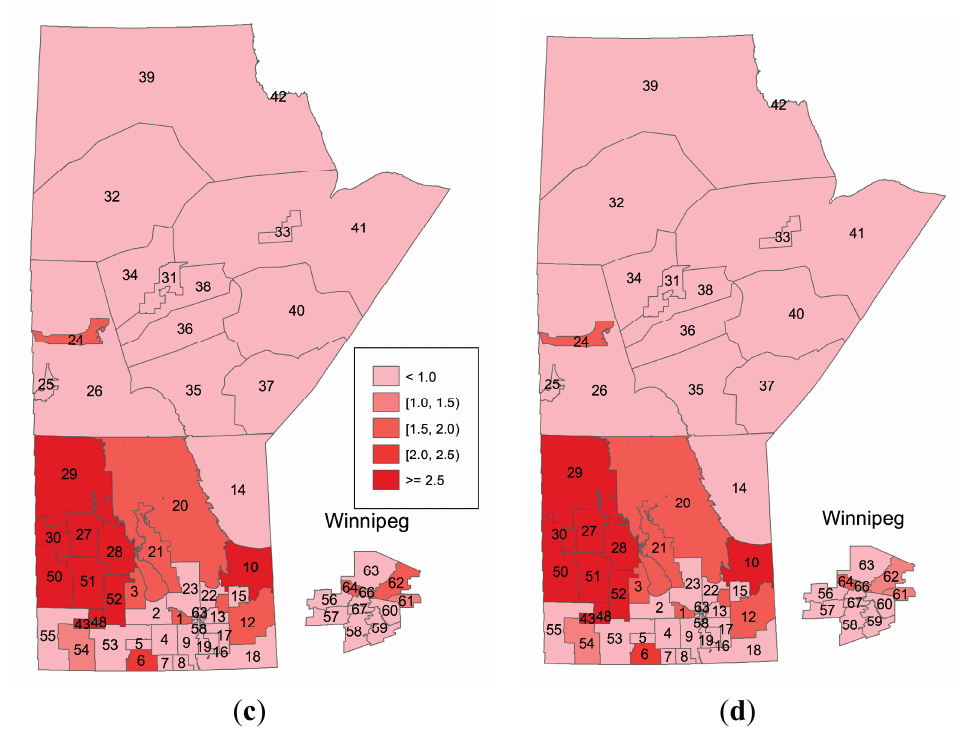
Figure 4. The order of most likely clusters of COPD for the CSS and FSS methods, and the special effects of the regional COPD risks for the BYM and MLE methods; in the case of cluster D. Major urban centre (Winnipeg region) is incorporated as an